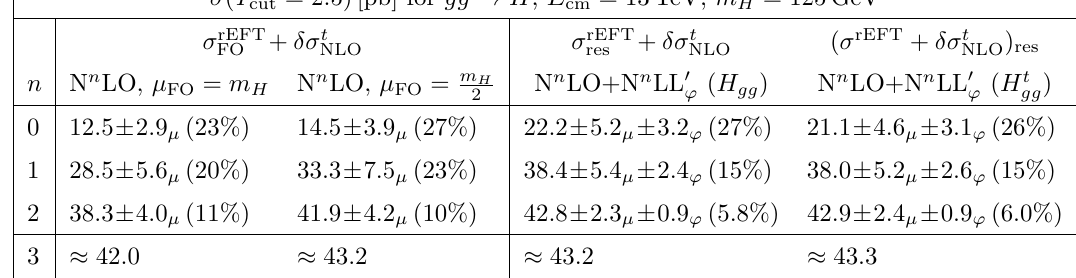
Table 2 . Cross section for gg ! H with a rapidity cut of Y cut = 2 : 5. All results include the exact m t dependence (cid:14)(cid:27) t ( Y cut ) at NLO. The percent uncertainties for the resummed results correspond to the total uncertainty (cid:1) (cid:22) (cid:8) (cid:1) ’ . The approximate n = 3 results are constructed as explained in the text and are given for illustration